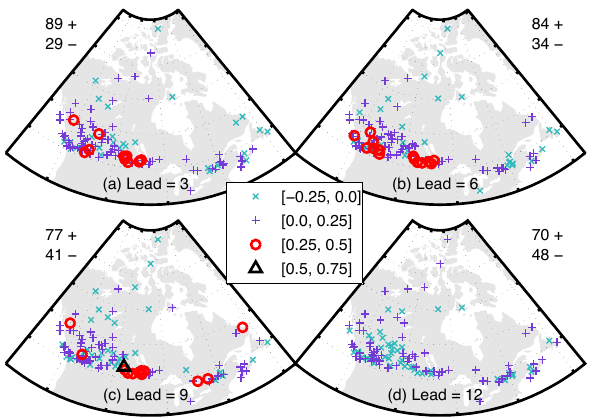
Fig. 9. Difference between the forecast correlation skills of the non- linear SVR model (SVR-R) and that of the linear SVR model (SVR- L) at lead times of (a) 3, (b) 6, (c) 9 and (d) 12months. The two numbers beside each panel give the number of stations where the SVR-R correlation is higher (lower) than that of the SVR-L model, as indicated by the + ( − ) sign.